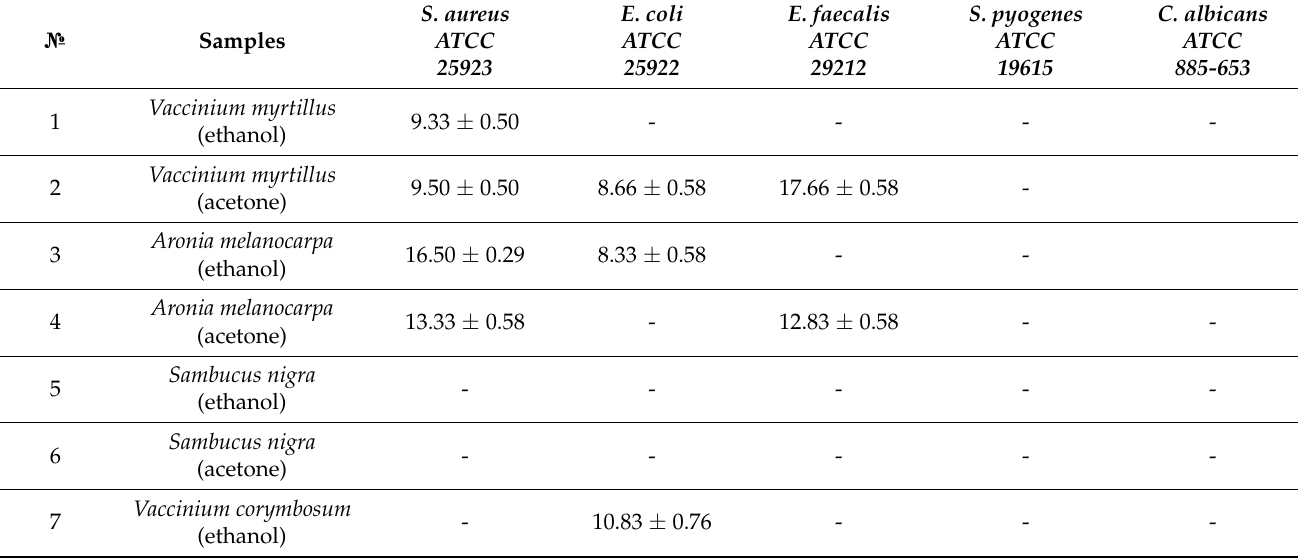
Table 6. Antimicrobial activity of anthocyanins against typical strains, zones inhibition in millimeters including diameter of well, mm (n = 3, x ± SD). ( − : no